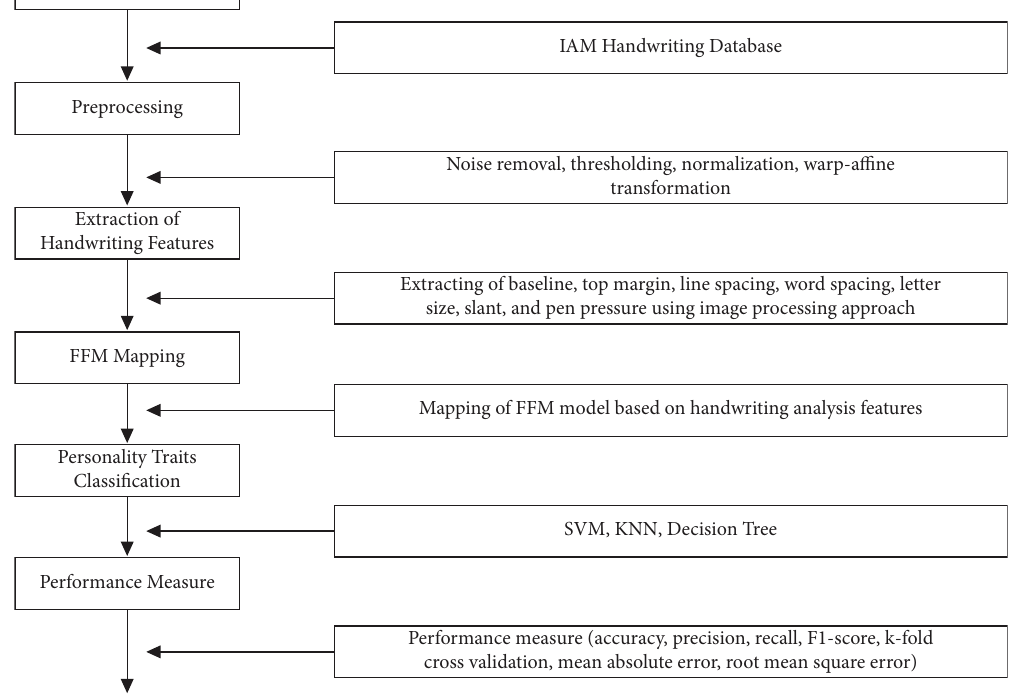
Figure 1: Proposed framework.